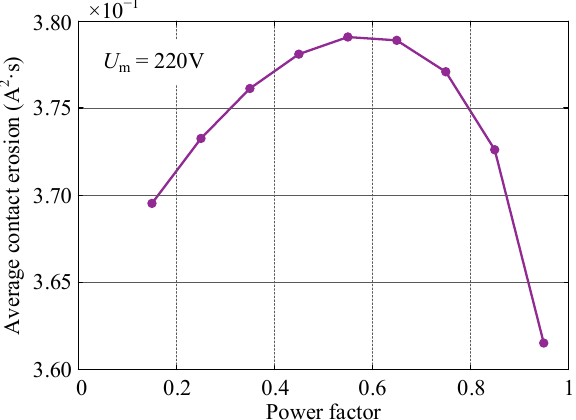
Figure 9. Average CEA curve under different power factors.